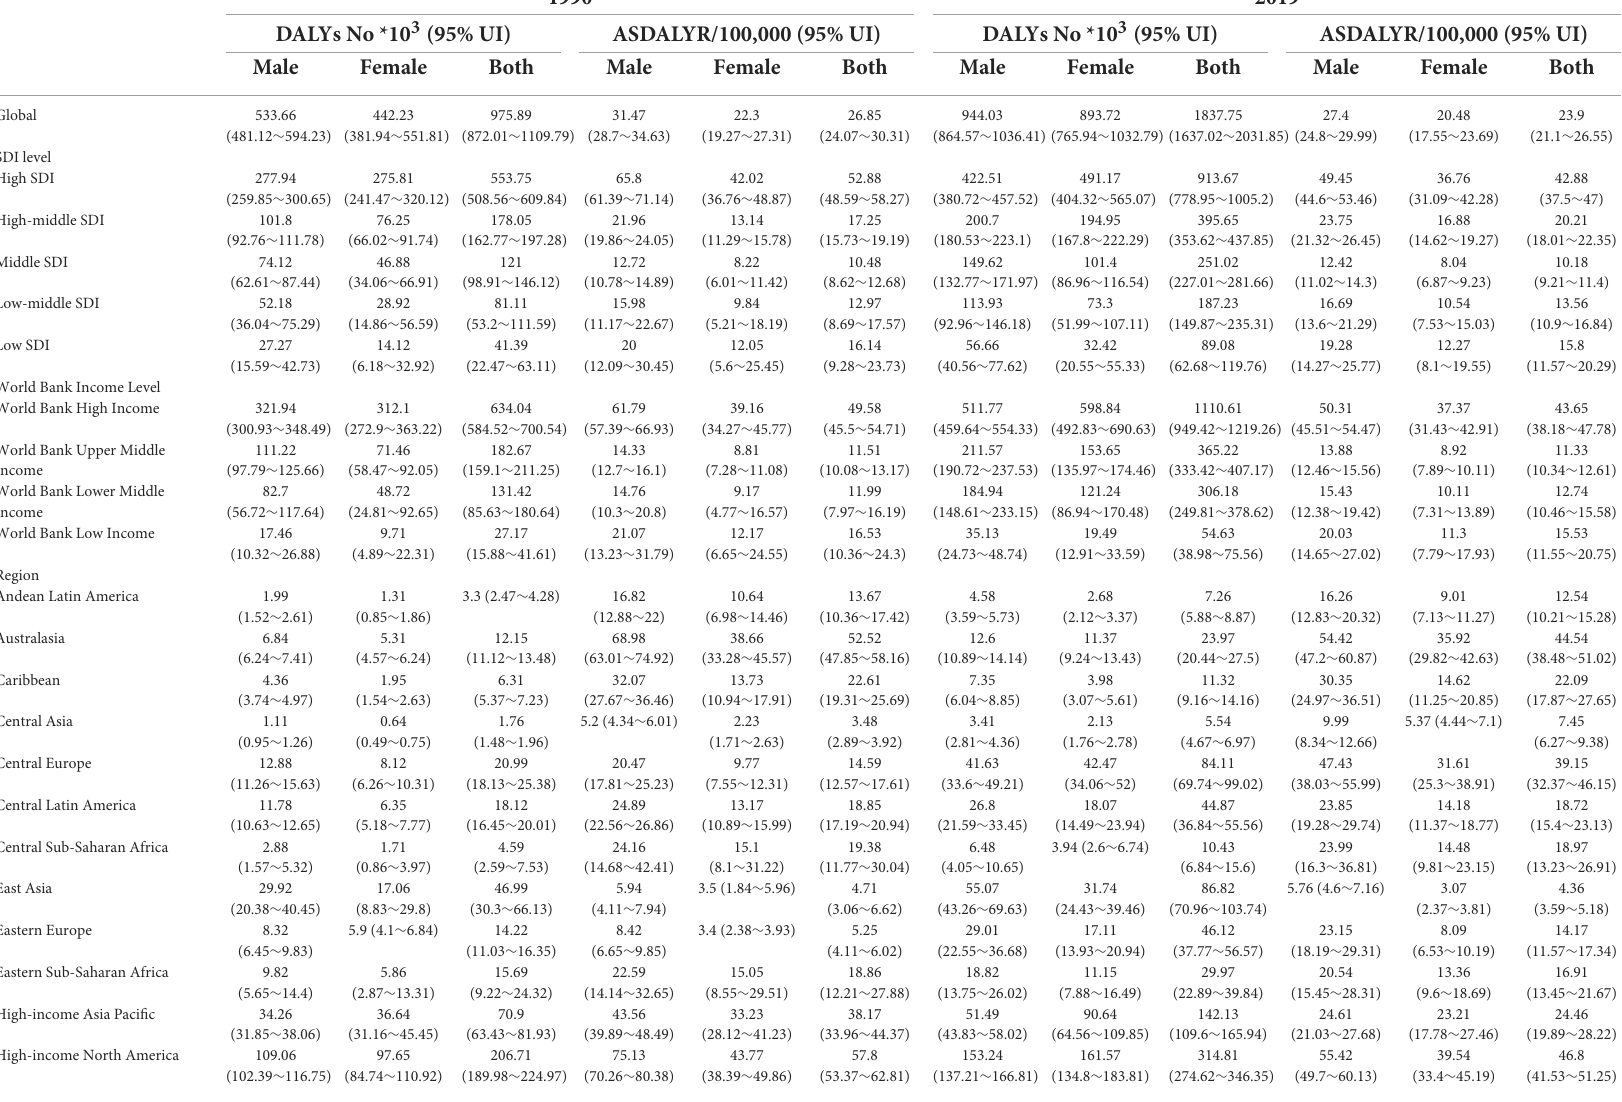
TABLE 4 The DALYs of CAVD in